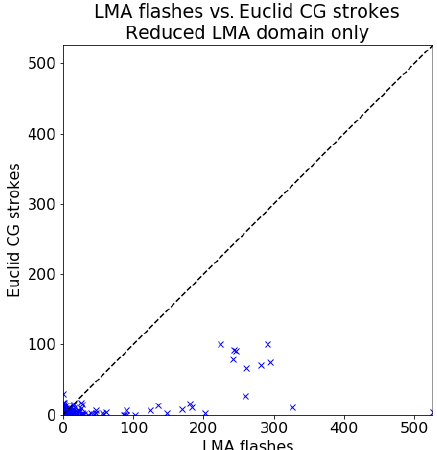
Figure 2. Scatter plot of the number of flashes detected by the LMA network with respect to the number of CG strokes detected by the EUCLID network within TRT cells when transiting through the re- duced